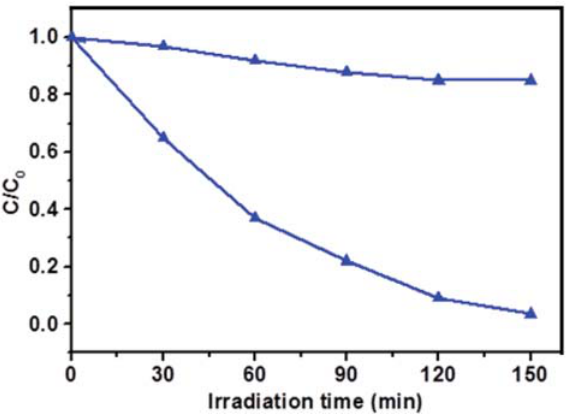
Figure 11. Photocatalytic degradation of MB in the presence of : (a) H O and (b) Co 2 2